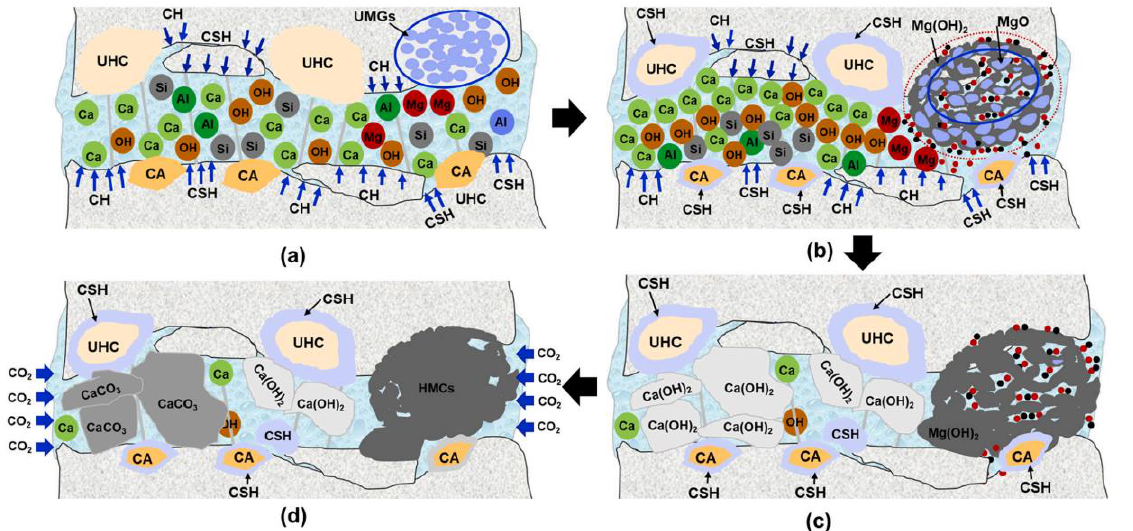
Figure 9. Self-healing mechanism of CA-MEA cementitious material ( a ) the crack has just opened, unhydrated grains exposed to crack solution, ( b ) various ions diffusion, ( c ) crystals formation, and ( d ) carbonation of crystals. Reprint with the permission from ref. [39]. Copyright 2022 Elsevier.